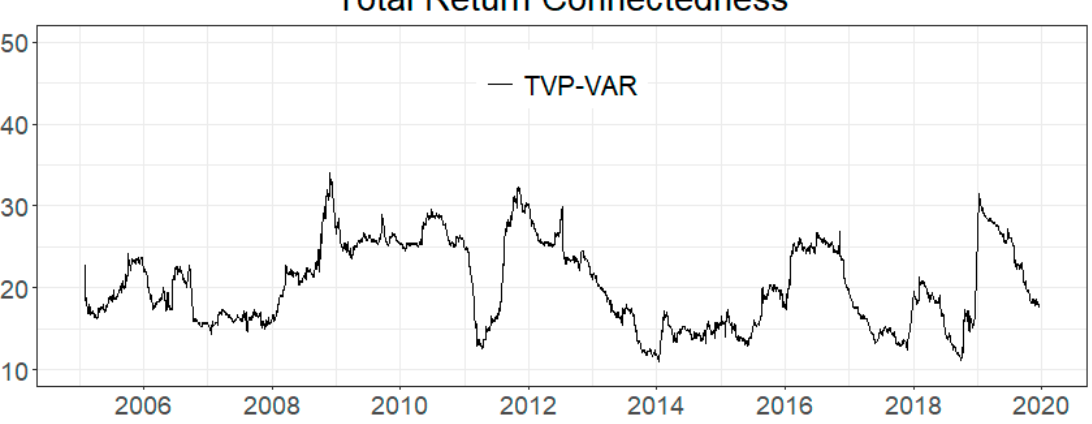
Figure 4. Dynamic total return connectedness. Note: the horizontal axis is the timeline; the vertical axis is the connected- ness.